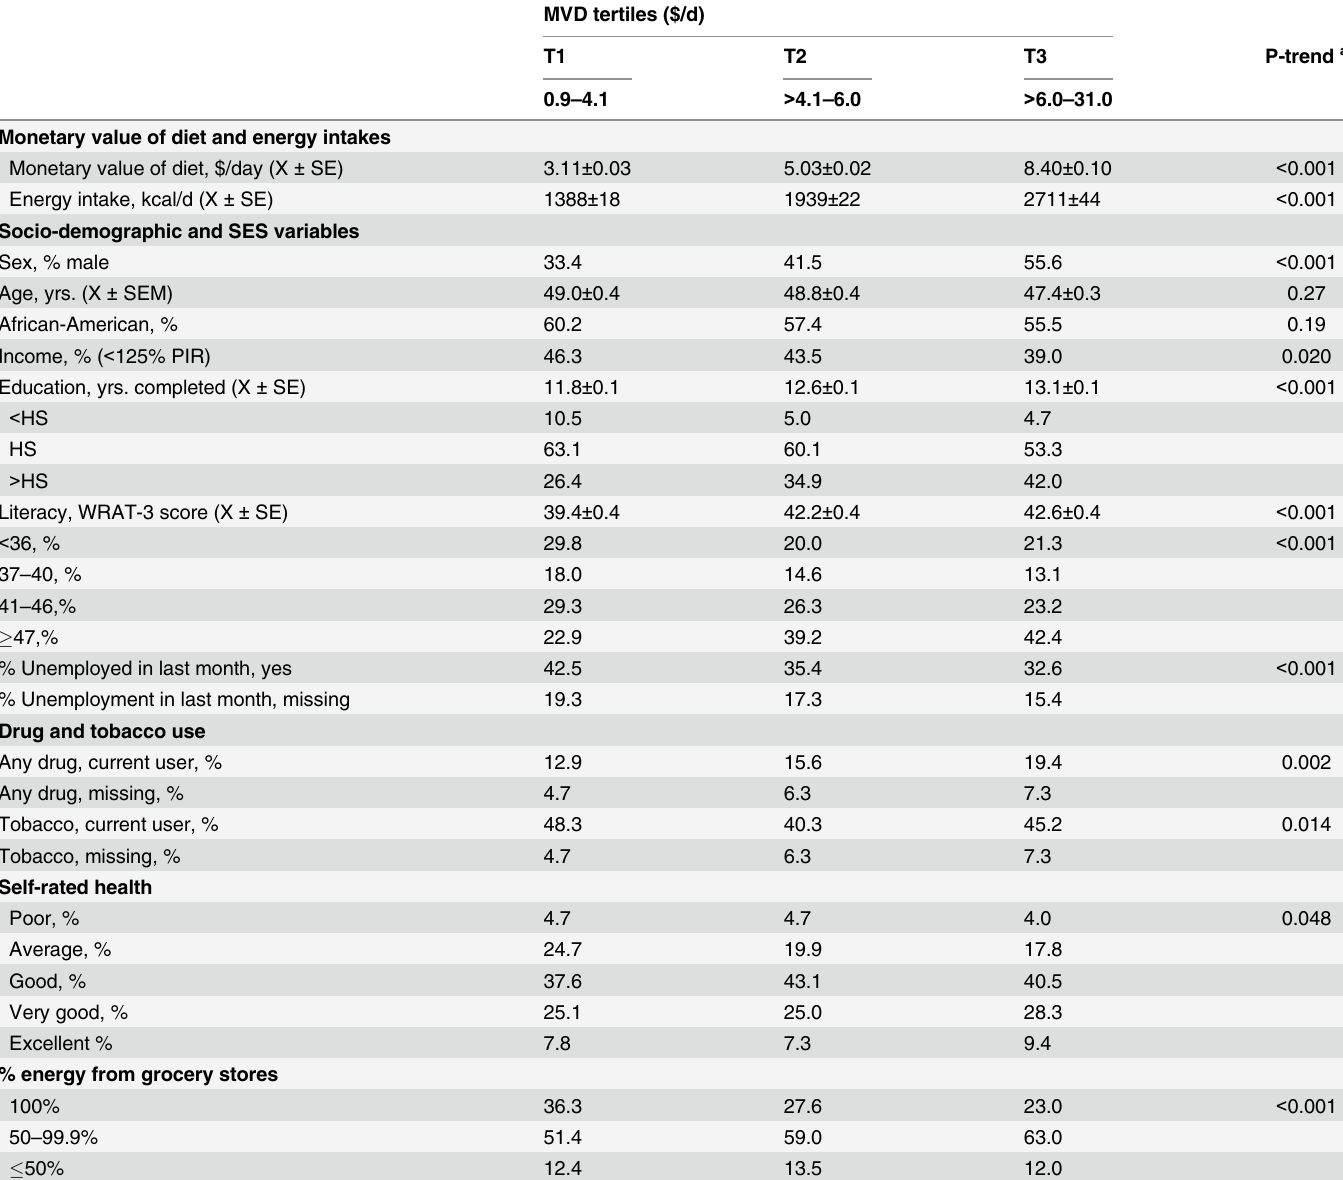
Table 1. Baseline characteristics of selected HANDLS sample by tertile of monetary value of diet (MVD) (N = 2111).